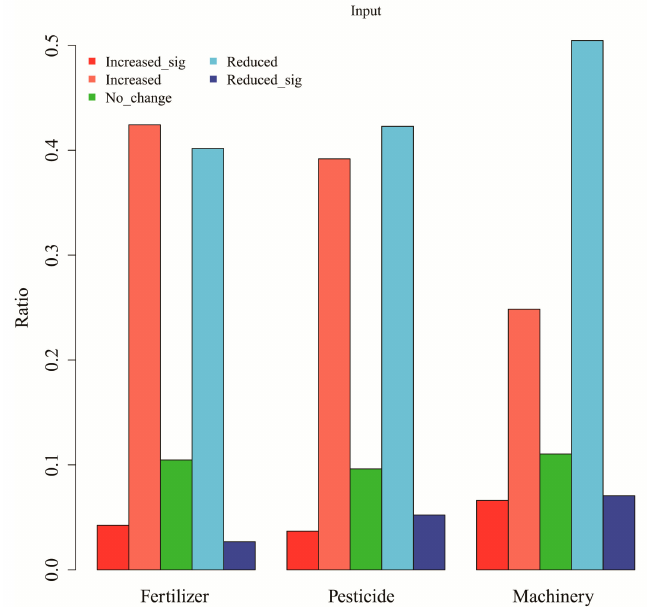
Figure3. Changesofinputsbyfamerswhohaveparticipatedintheplantingprogram. Theabbreviations are sig =